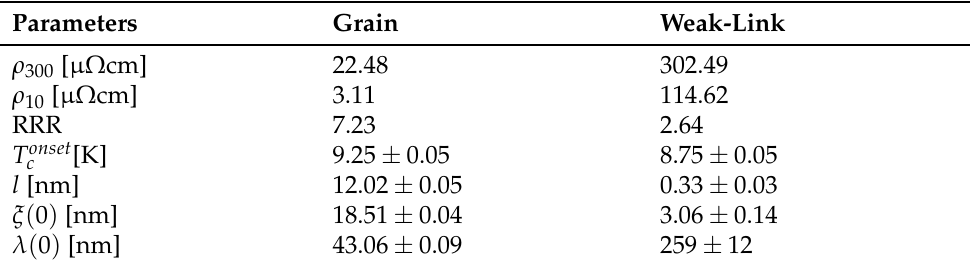
Table 1. Resistivity at 300 K and 10 K; RRR; Superconducting critical temperature, T c ; mean free path, l ; coherence length, ξ ( 0 ) ; penetration depth, λ ( 0 ) . All listed parameters were obtained for the grain and weak-link